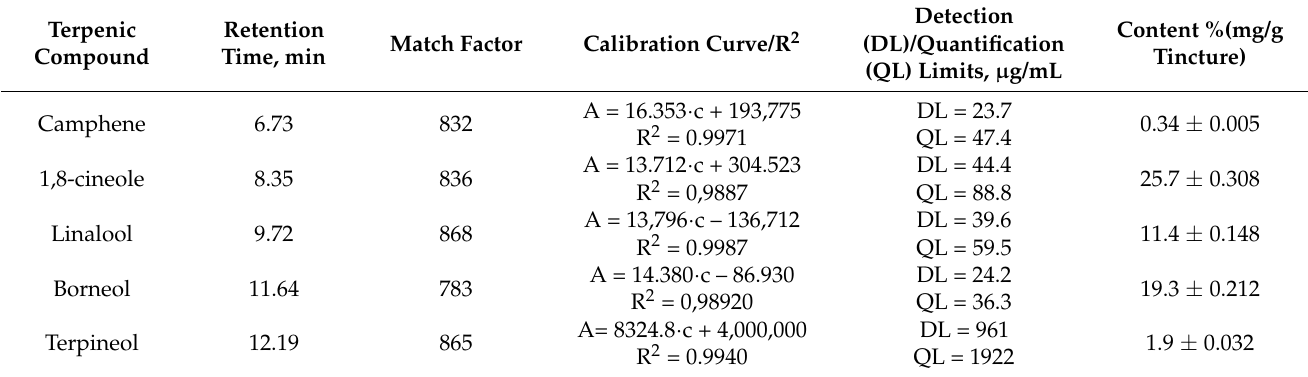
Detection Content %(mg/g (DL)/Quantification Tincture) (QL) Limits, µ g/mL DL = 23.7 0.34 ± 0.005 QL = 47.4 DL = 44.4 25.7 ± 0.308 QL = 88.8 DL = 39.6 11.4 ± 0.148 QL = 59.5 DL = 24.2 19.3 ± 0.212 QL = 36.3 DL = 961 1.9 ± 0.032 QL = 1922